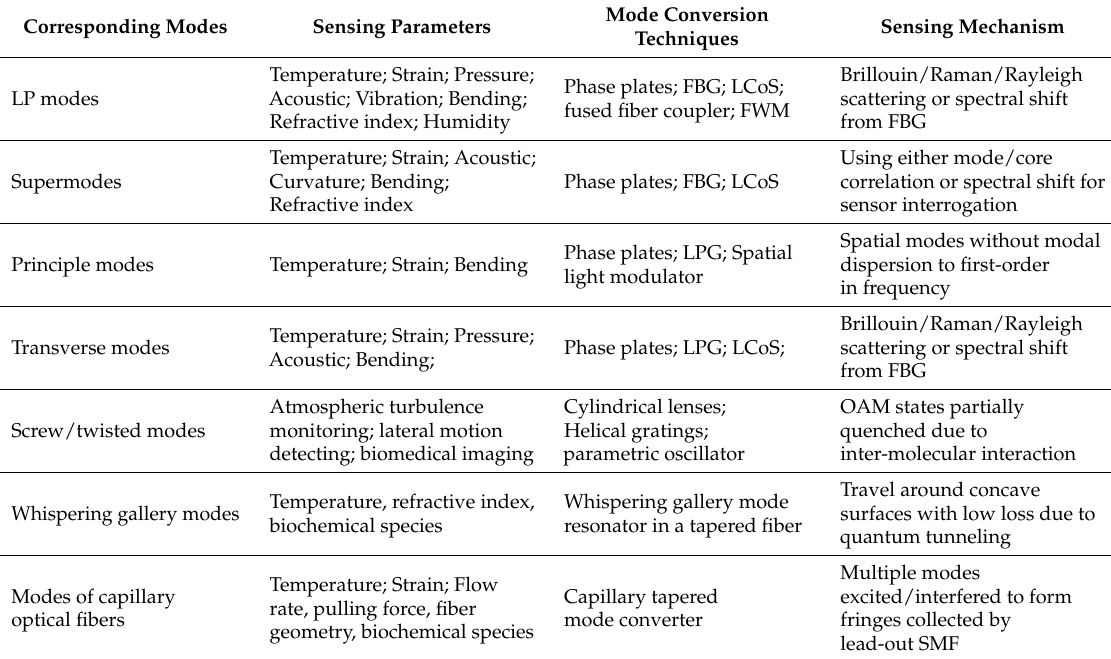
Table 6. Comparison of sensing parameters, mode conversion techniques and operation mechanism for different types of mode multiplexing.